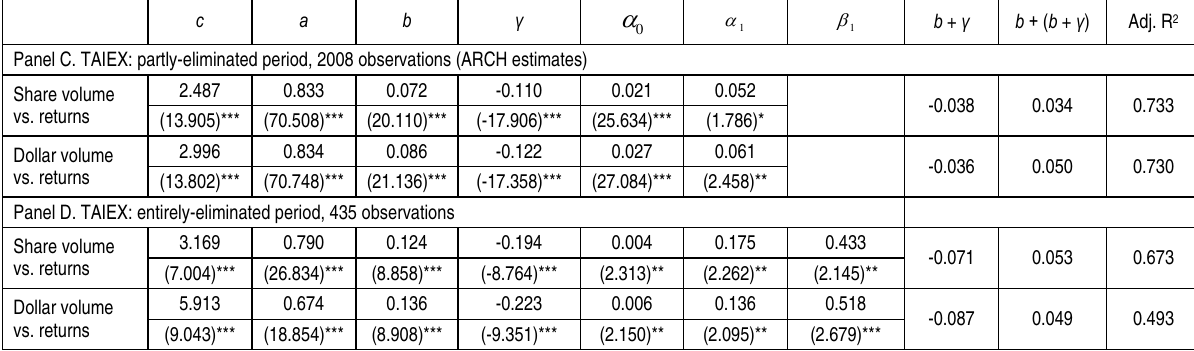
Table 4 (cont.). GARCH (1,1) estimates of volume-signed return correlation